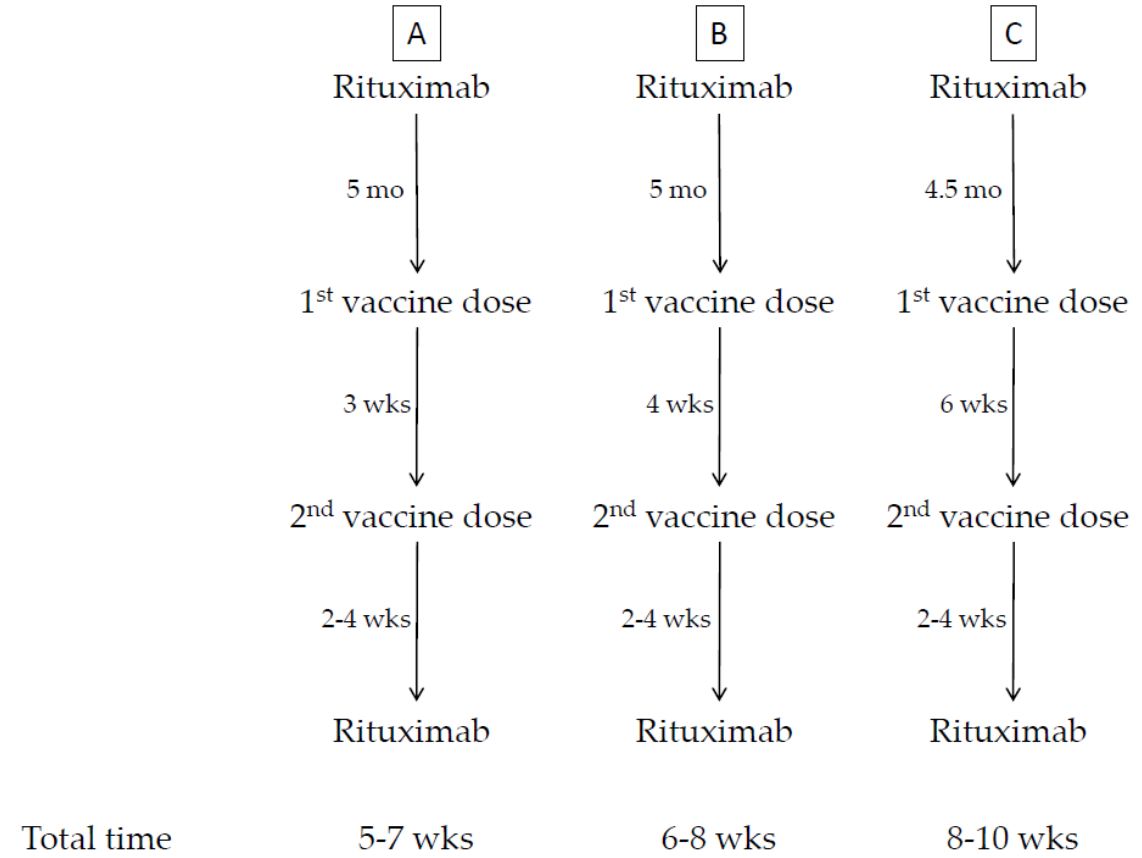
Figure 1. Proposed protocol of time intervals between ongoing therapy with rituximab and anti-COVID-19 vaccination. The time intervals between two consequent treatments with rituximab and anti-COVID-19 vaccination are provided. Total time indicates the duration of the postponement of the next scheduled cycle of rituximab since the first vaccination. ( A ) Vaccination with BNT162 vaccine (Comirnaty, Pfizer) following the time interval between the two doses as approved in the label. ( B ) Vaccination with mRNA-1273 vaccine (Spikevax, Moderna) following the time interval between the two doses as approved in the label. ( C ) Vaccination with either BNT162 vaccine (Comirnaty, Pfizer) or mRNA-1273 vaccine (Spikevax, Moderna) with delay between the two doses, as implemented in Italy. Abbreviations: mo, months; wks, weeks. Table 6. Guide to using anti-COVID-19 vaccination in patients with AIAIDs under immunosuppressive treatment [from Ref. [103] modified]. Drug Modification of Therapy Modification of Therapy in Relation to